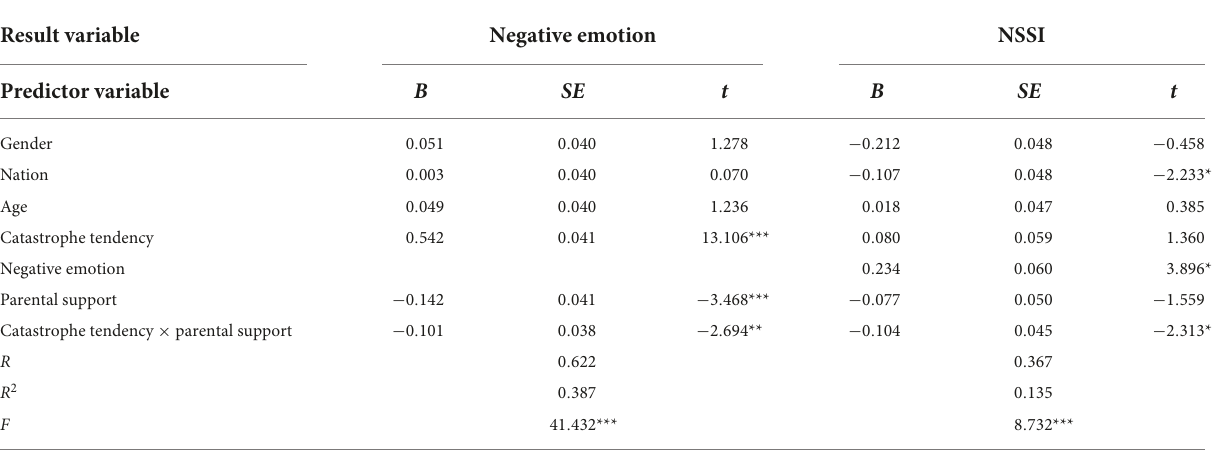
TABLE 2 Moderated mediation model test of parental support ( N =